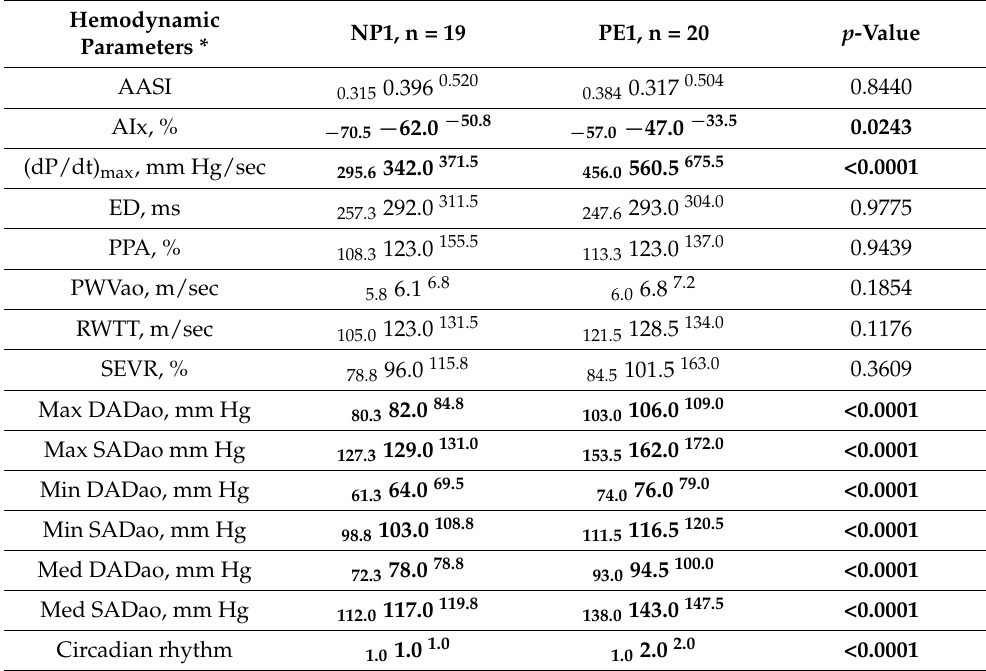
Table 3. Differences in hemodynamic parameters in patients with healthy pregnancy and patients with early-onset PE.